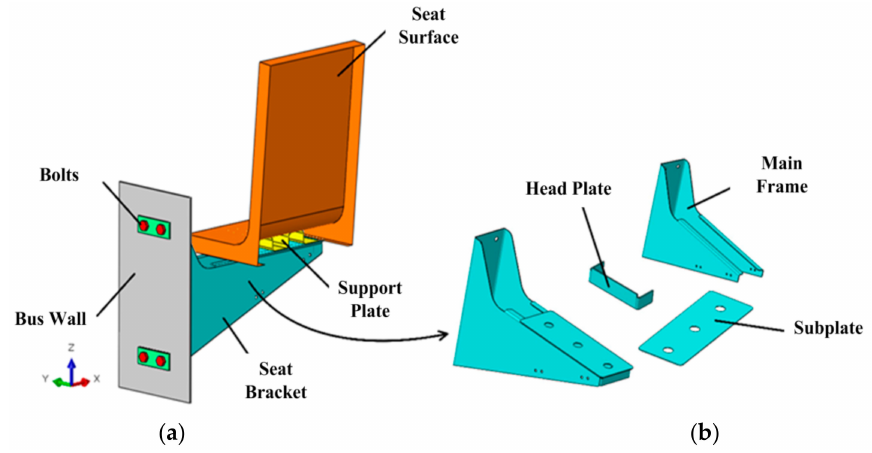
Figure 1. Structural schematic diagram of one seat ( a ) and ( b ) initial seat bracket.